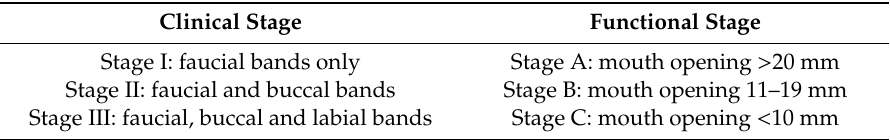
Table 1. Oral submucous fibrosis (OSF) staging / classification system.